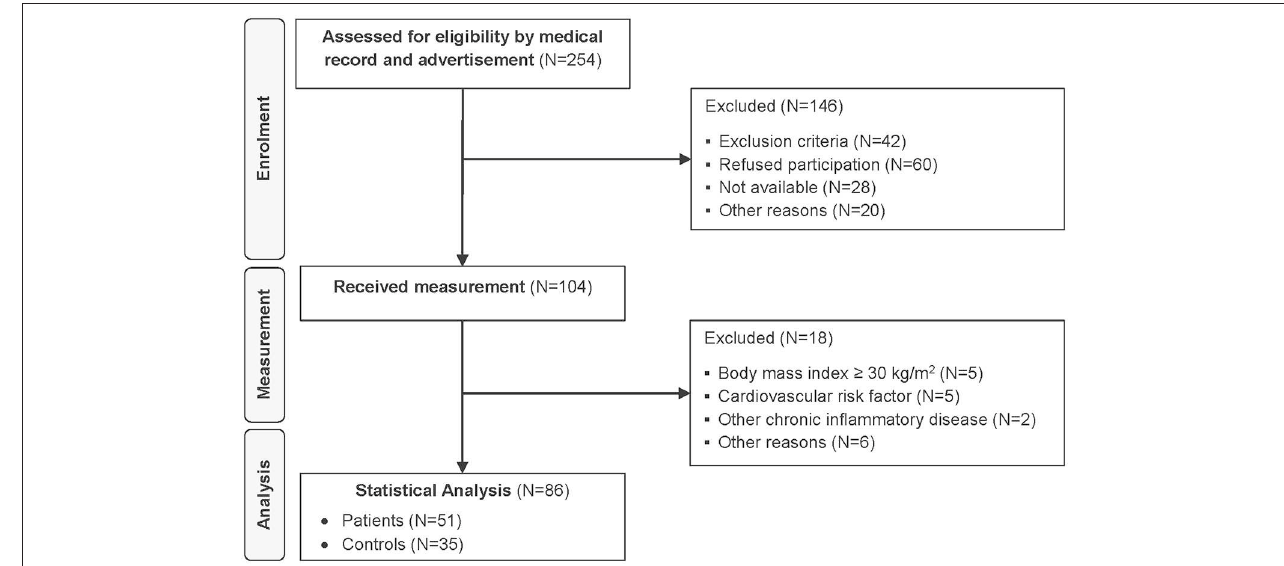
FIGURE 2 | Flow diagram.